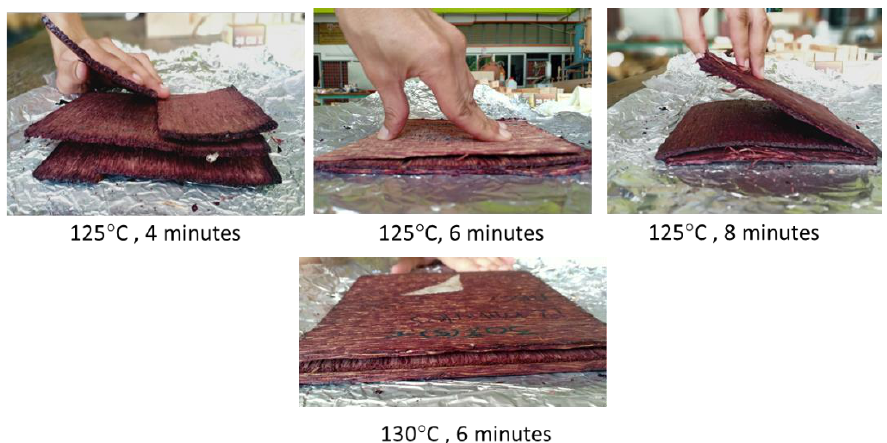
Figure 3. Plywood produced using designated pressing temperatures and times showed failure in bonding.